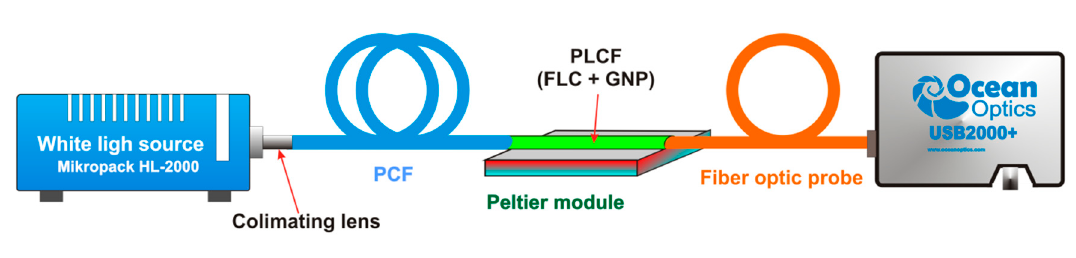
Figure 4. Setup used for spectral measurements for the function of temperature.